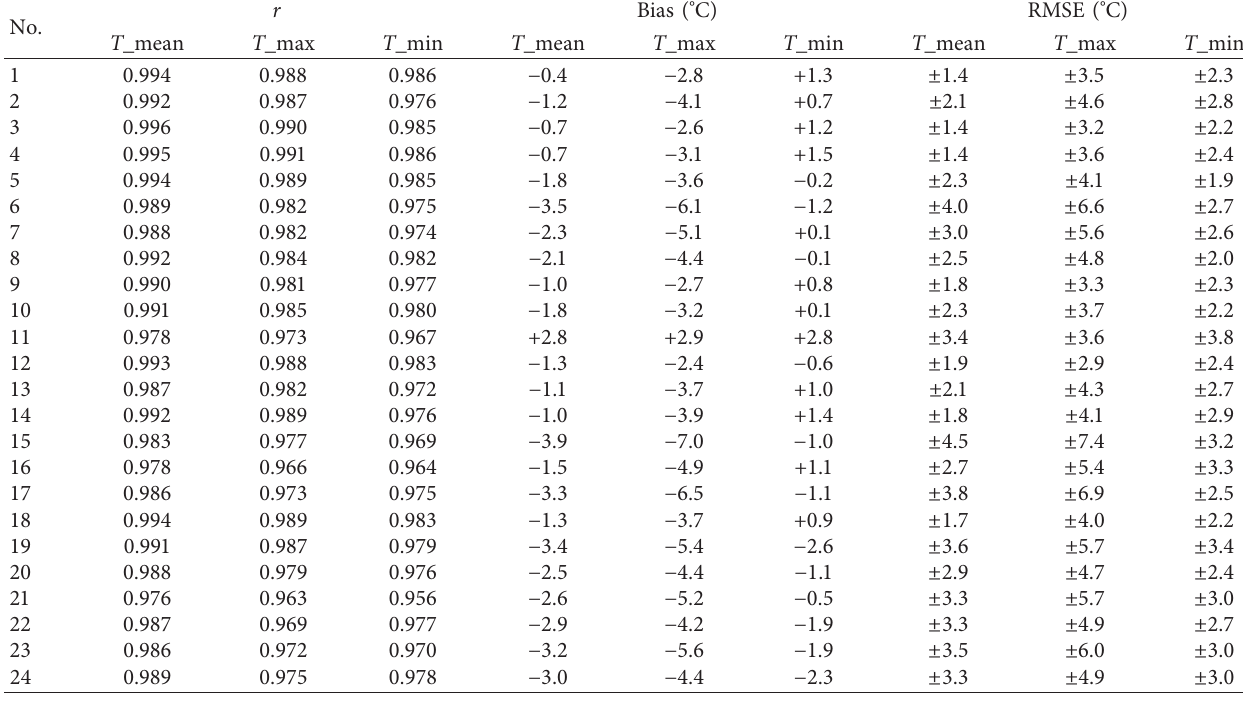
Table 2: Comparison of ERA-Interim daily temperature with observations at all 24